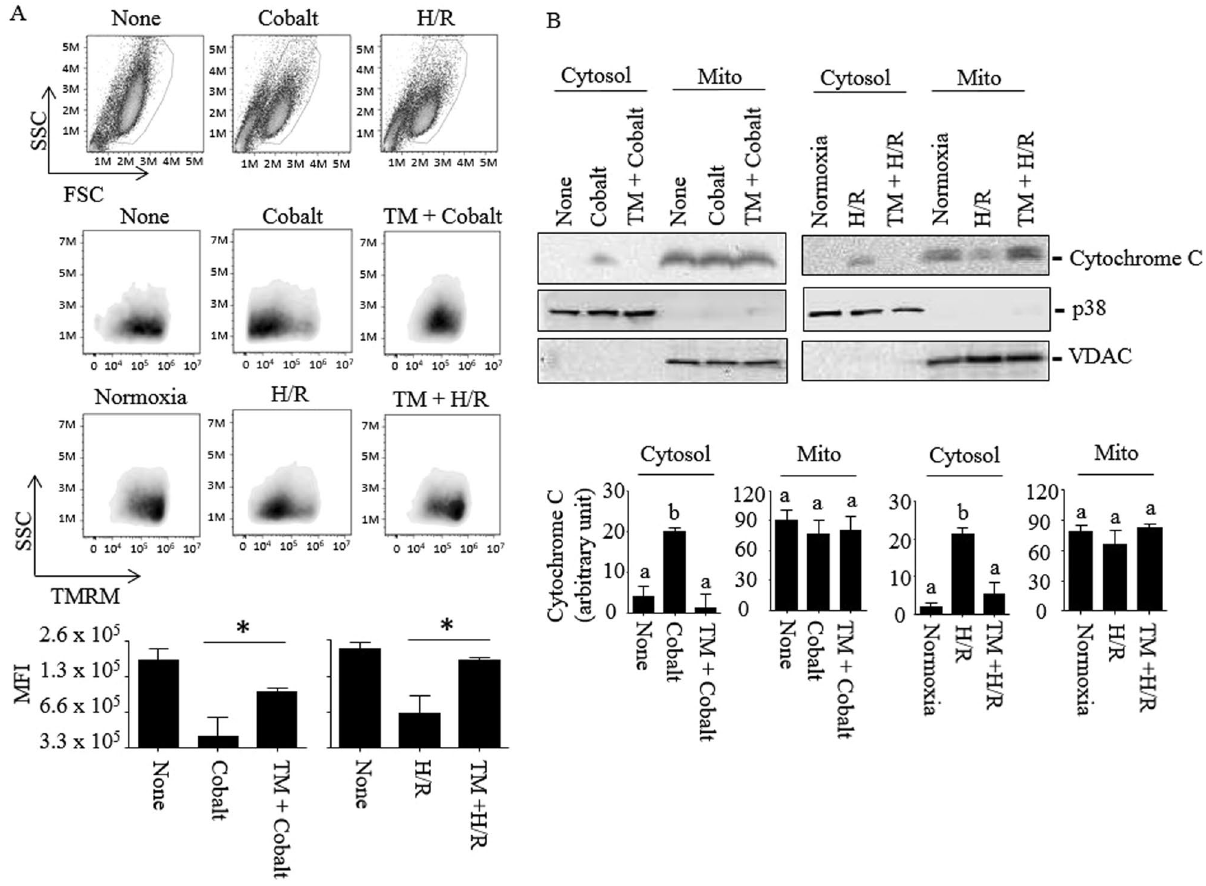
Figure 2. TM protects HK-2 cells from mitochondrial membrane dysfunction induced by cobalt and H/R. ( A ) HK-2 cells were exposed to nothing, cobalt (300 µ M) for 16–18 h or H/R [incubated in the hypoxia chamber (0.2% O 2 , 5% CO 2 & 95% N 2 at 37 °C) for 24 h, then in a standard cell culture incubator (~21% O 2 , 5% CO 2 & ~74% N 2 at 37 °C) for the next 6 h] in the presence or absence of TM (25 µ M). Cells were then stained with the mitochondrial membrane potential probe TMRM and analyzed by FACS as described in “ Methods ”. Cells with normal morphological features, based on forward and side scattered light parameters, were gated for mitochondrial membrane depolarization measurement (top panel, circled). TMRM fluorescence (middle panel) and median fluorescence intensities (bottom panel) were plotted using the FlowJo software. FACS images shown are representative of three (cobalt) and two (H/R) independent experiments. Data are expressed as mean ± S.D. ( * p < 0.05; Student’s t -test). ( B ) Similarly, HK-2 cells were treated with cobalt or H/R and the cytosolic and mitochondrial fractions prepared as described in “ Methods ”. Release of cytochrome C from mitochondria to the cytosol was measured by immunoblots (upper panel). Immunoblots against anti-p38 and anti-VDAC were used for loading controls and markers for differential cell lysate preparations. Images shown are representative of three independent experiments. Cytochrome C band intensities relative to corresponding loading controls were analyzed by NIH images J program (lower panel). Data are expressed as mean ± S.D. [p < 0.05 by one-way ANOVA with Tukey multiple comparison test; columns accompanied by the same letter are not significantly different from each